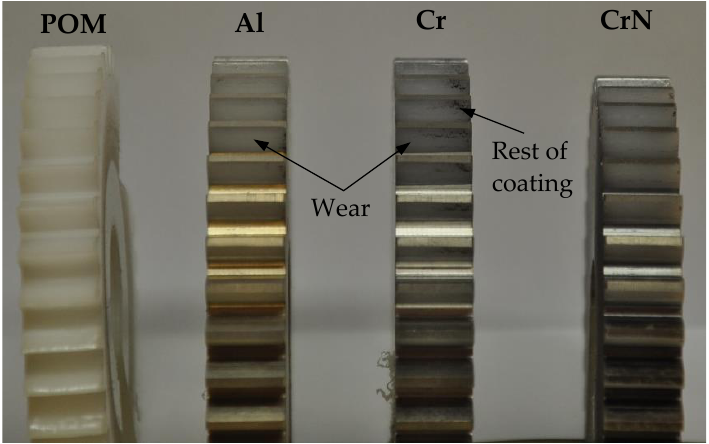
Figure 14. A photograph of the worn gears.